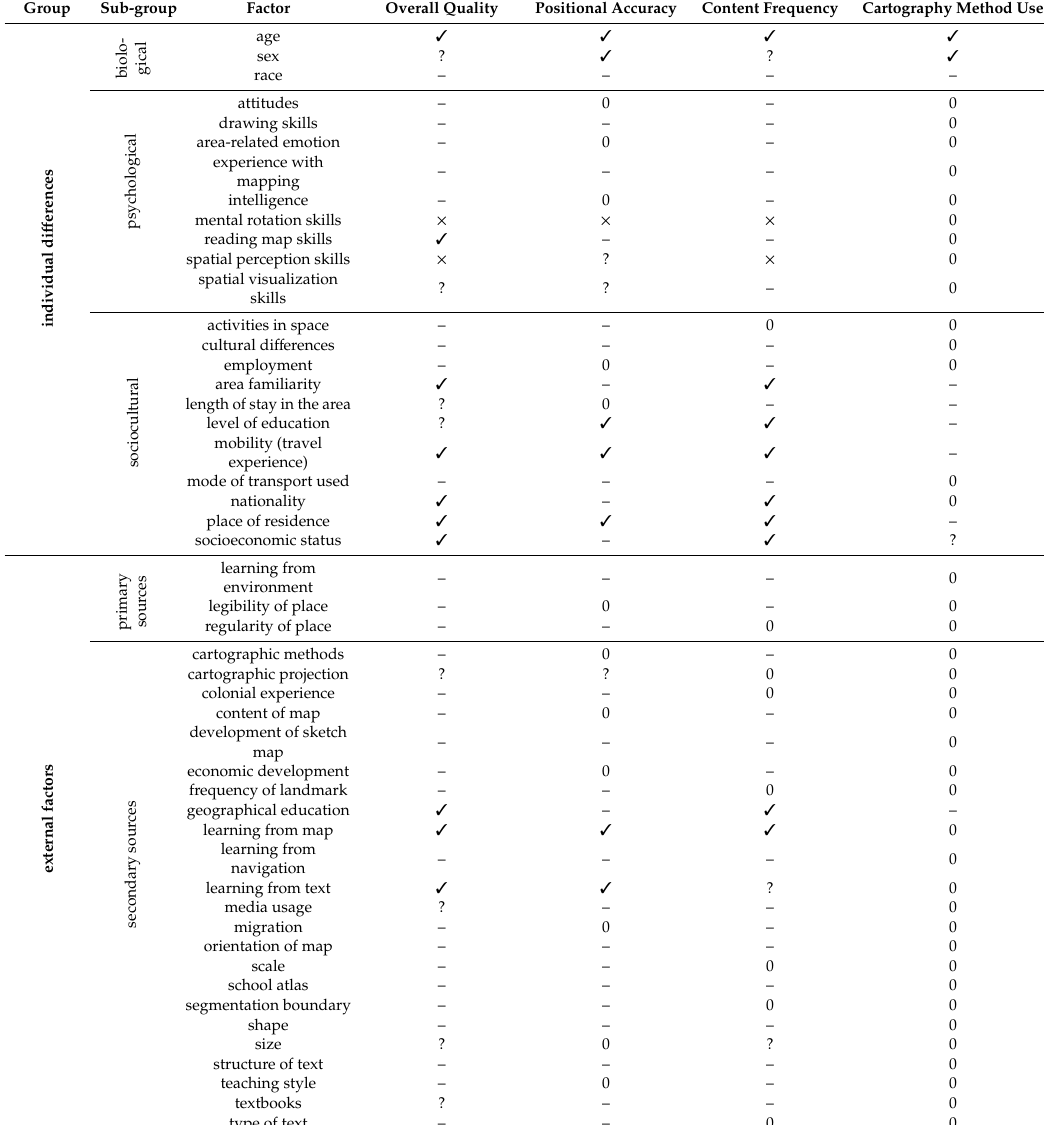
Table 2. The provability of factors within the framework of overall sketch map quality and its parameters ( (cid:51) : proven; × : refuted; ?: debatable; –: insu ffi cient number of studies; 0: not